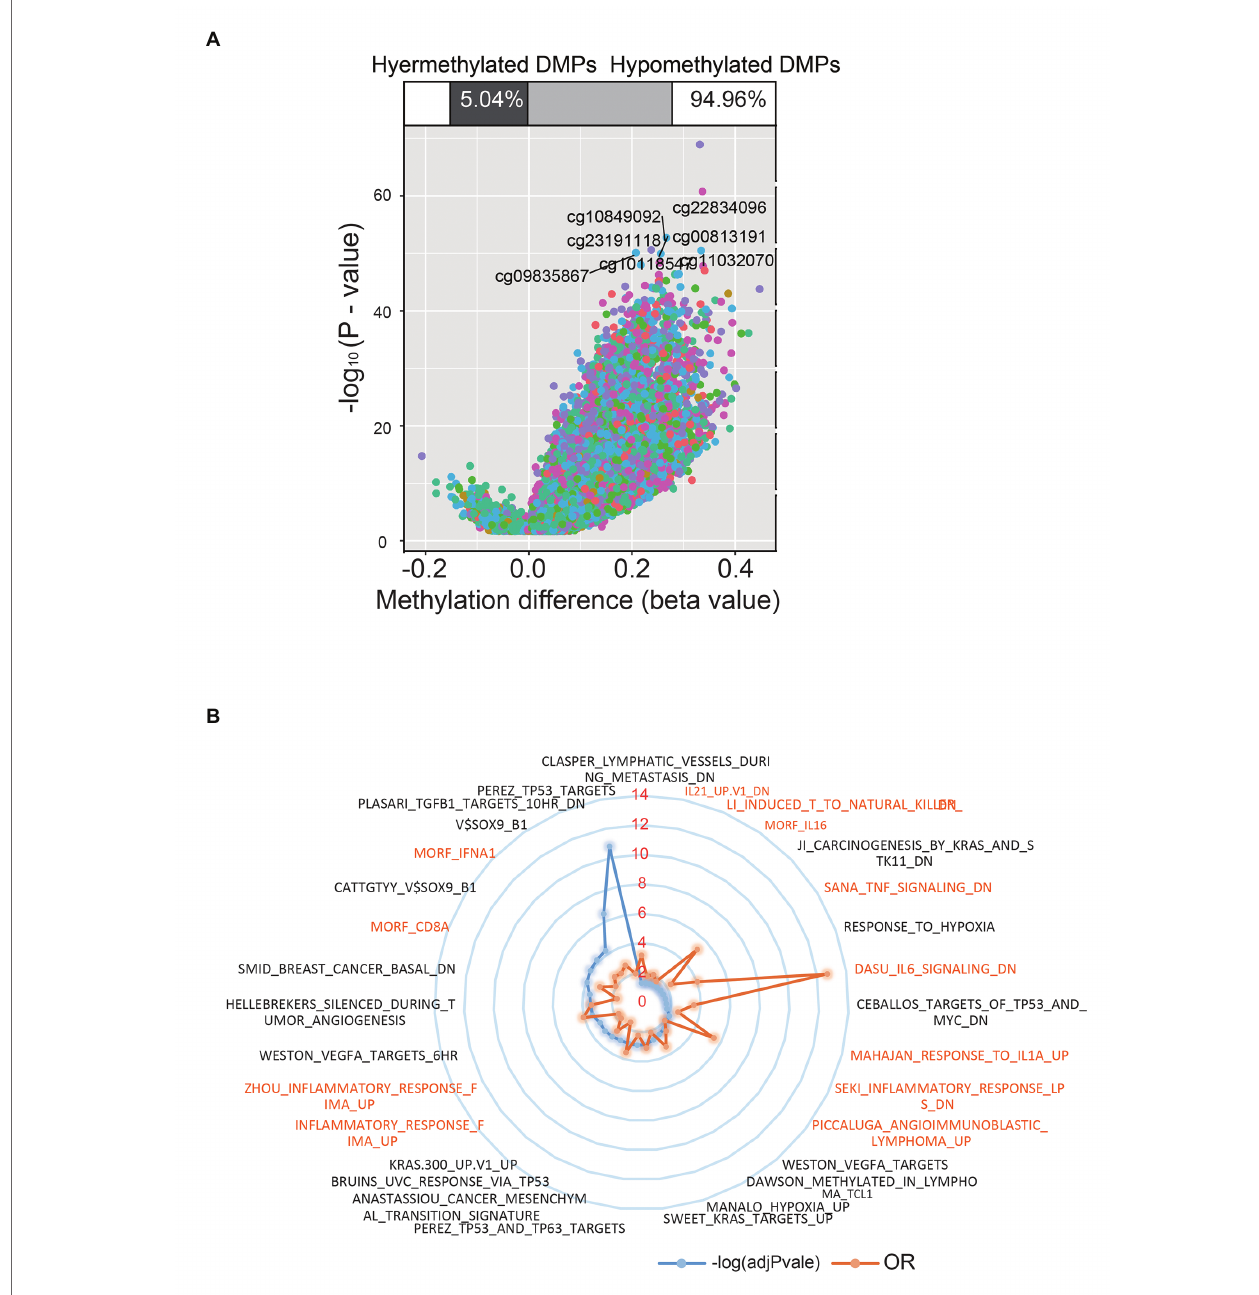
FIGURE 4 | Differential methylation sites between DNAmAge-ACC and DNAmAge-DEC group. Using ChAMP, we identified 77,186 differential methylation probes in samples of 70 DNAmAge-ACC and 318 DNAmAge-DEC samples (A) . Gene set enrichment analysis (GSEA) identified immune-related signaling pathways (B)